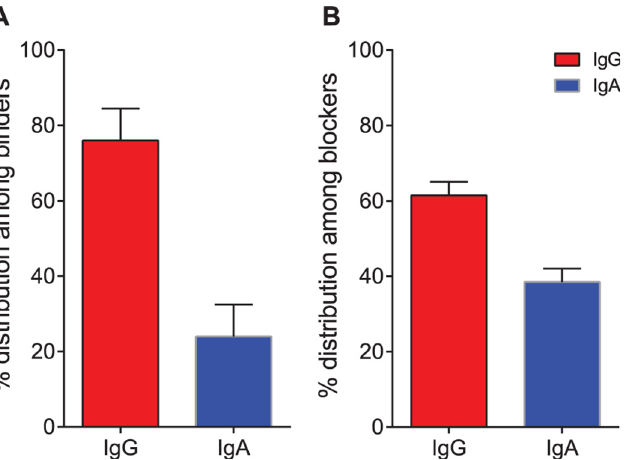
Fig 1. Screening supernatants of EBV-transformed B cell cultures from two NoV-challenged subjects. B cell culture supernatants were added to replicate microtiter plates coated with NoV VLP and probed with a mixture of (i) a mixture of anti-human ( κ + λ ; to determine the total number of binders), or (ii) anti-human IgG ( γ -specific; to determine IgG frequency), or (iii) anti-human IgA ( α -specific; to determine the IgA frequency) secondary antibodies. Blocking assay was done as described in Methods. The number of binding (A450 > 1.5) and blocking (A450 < 2.1) were counted and percent distribution among binders and blockers was calculated. Distribution of IgG (red) or IgA (blue) classes of antibodies that bound to NoV VLP (A) or blocked VLP — glycan interaction (B) is shown.